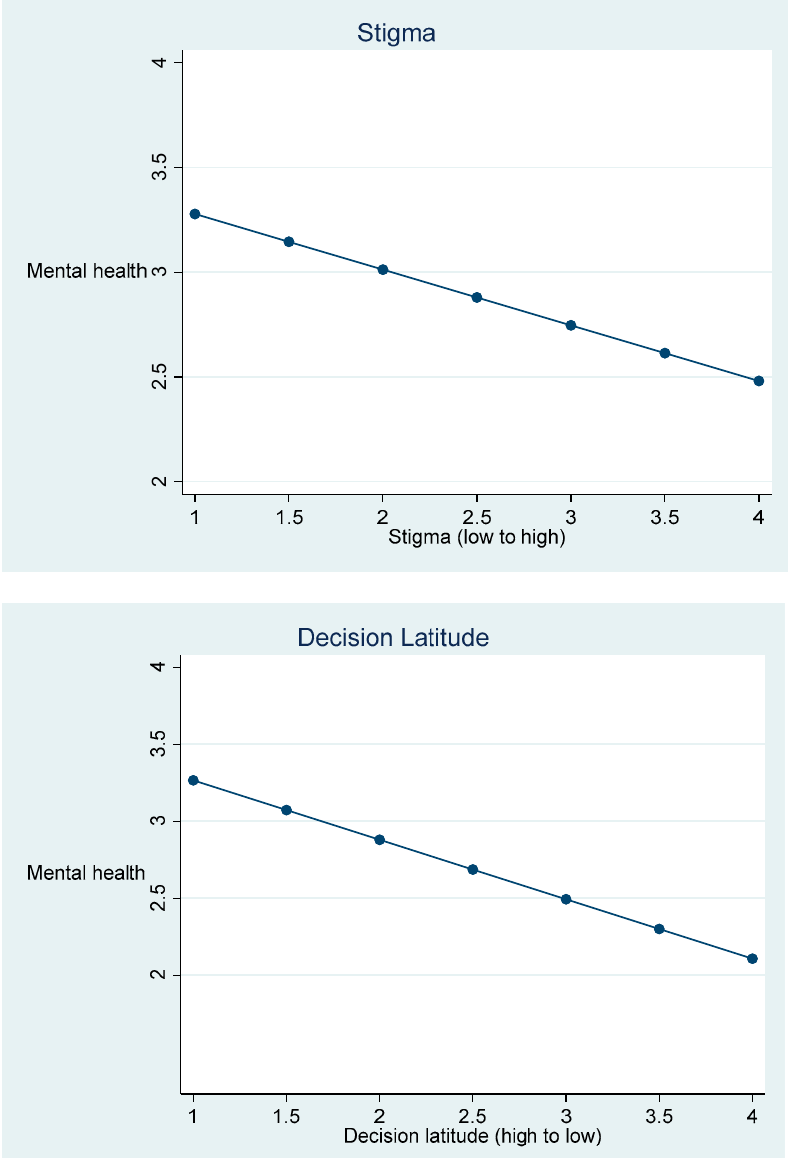
Figure 1. Predicted values, mental health, and job attributes in sex work. The graphs for job insecurity and stigma for hairstyling follow similar patterns to those for sex work (see Figure 2). The predicted mental health scores were approximately 38% higher for people with low job insecurity compared to those whose job insecurity was high and about 40% higher for people who reported low levels of stigma compared to those with reported high levels of it. Results for self-employment indicated predicted mental health scores that were 1.36 points higher for self-employed stylists compared to those who were employees in a salon or shop (results not graphed). The results for changes in the employment status indicated that someone who became self-employed during the study improved his/her predicted mental health score by 1.20 points.